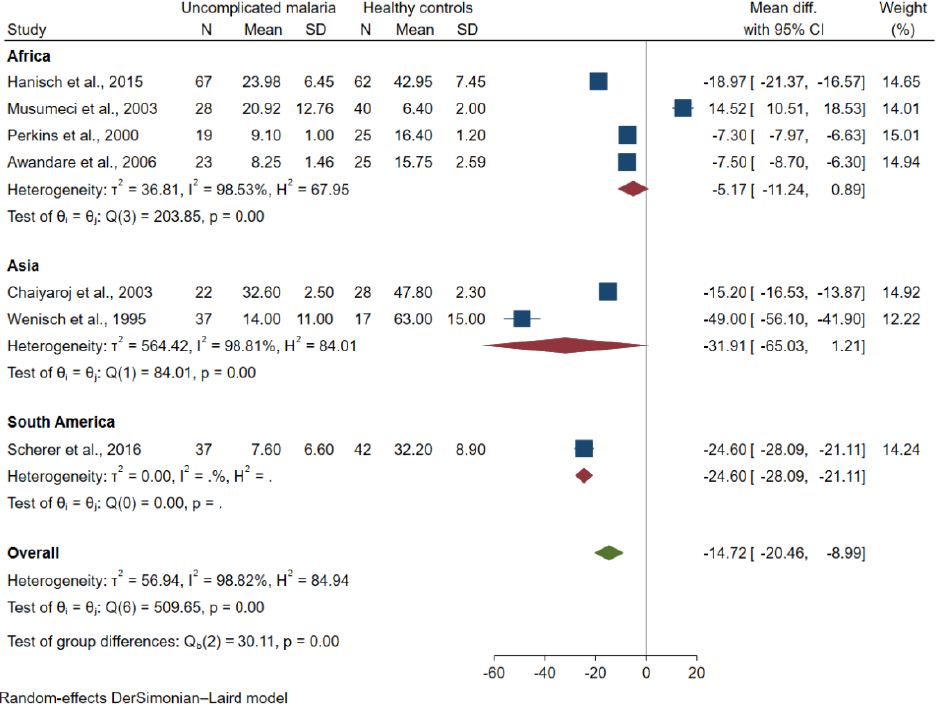
Figure 4. Forest plot demonstrating a difference in mean TGF-β levels (pg/mL) in uncomplicated malaria and healthy controls by age groups [26,27,33,38–40,42]. Grey y -axis line, line of no effect